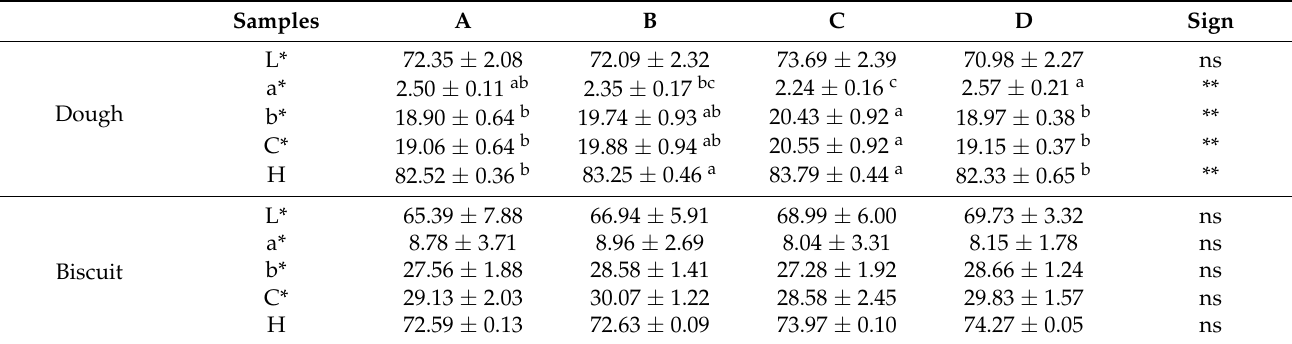
Table 4. Color parameters of dough and biscuit